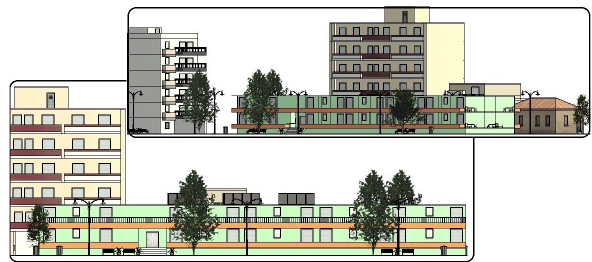
Figure 4. The western and north-western facet of the BIM representing the test building (in green and orange)